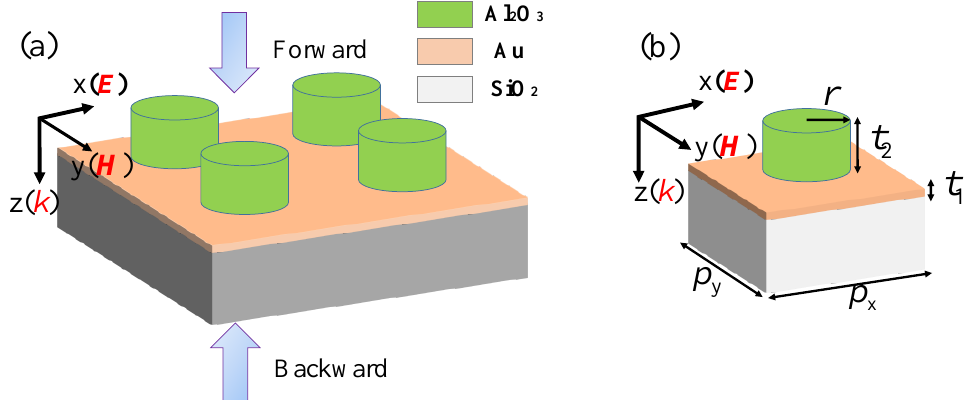
Figure 1. Schematic diagrams of the proposed dielectric–metal metasurface. ( a ) Perspective view of the structural unit arrays of the dielectric–metal metasurface. ( b ) The optimized geometrical parameters of one unit: p x = p y = 700 nm, t 1 = 20 nm, t 2 = 200 nm, r = 200 nm.